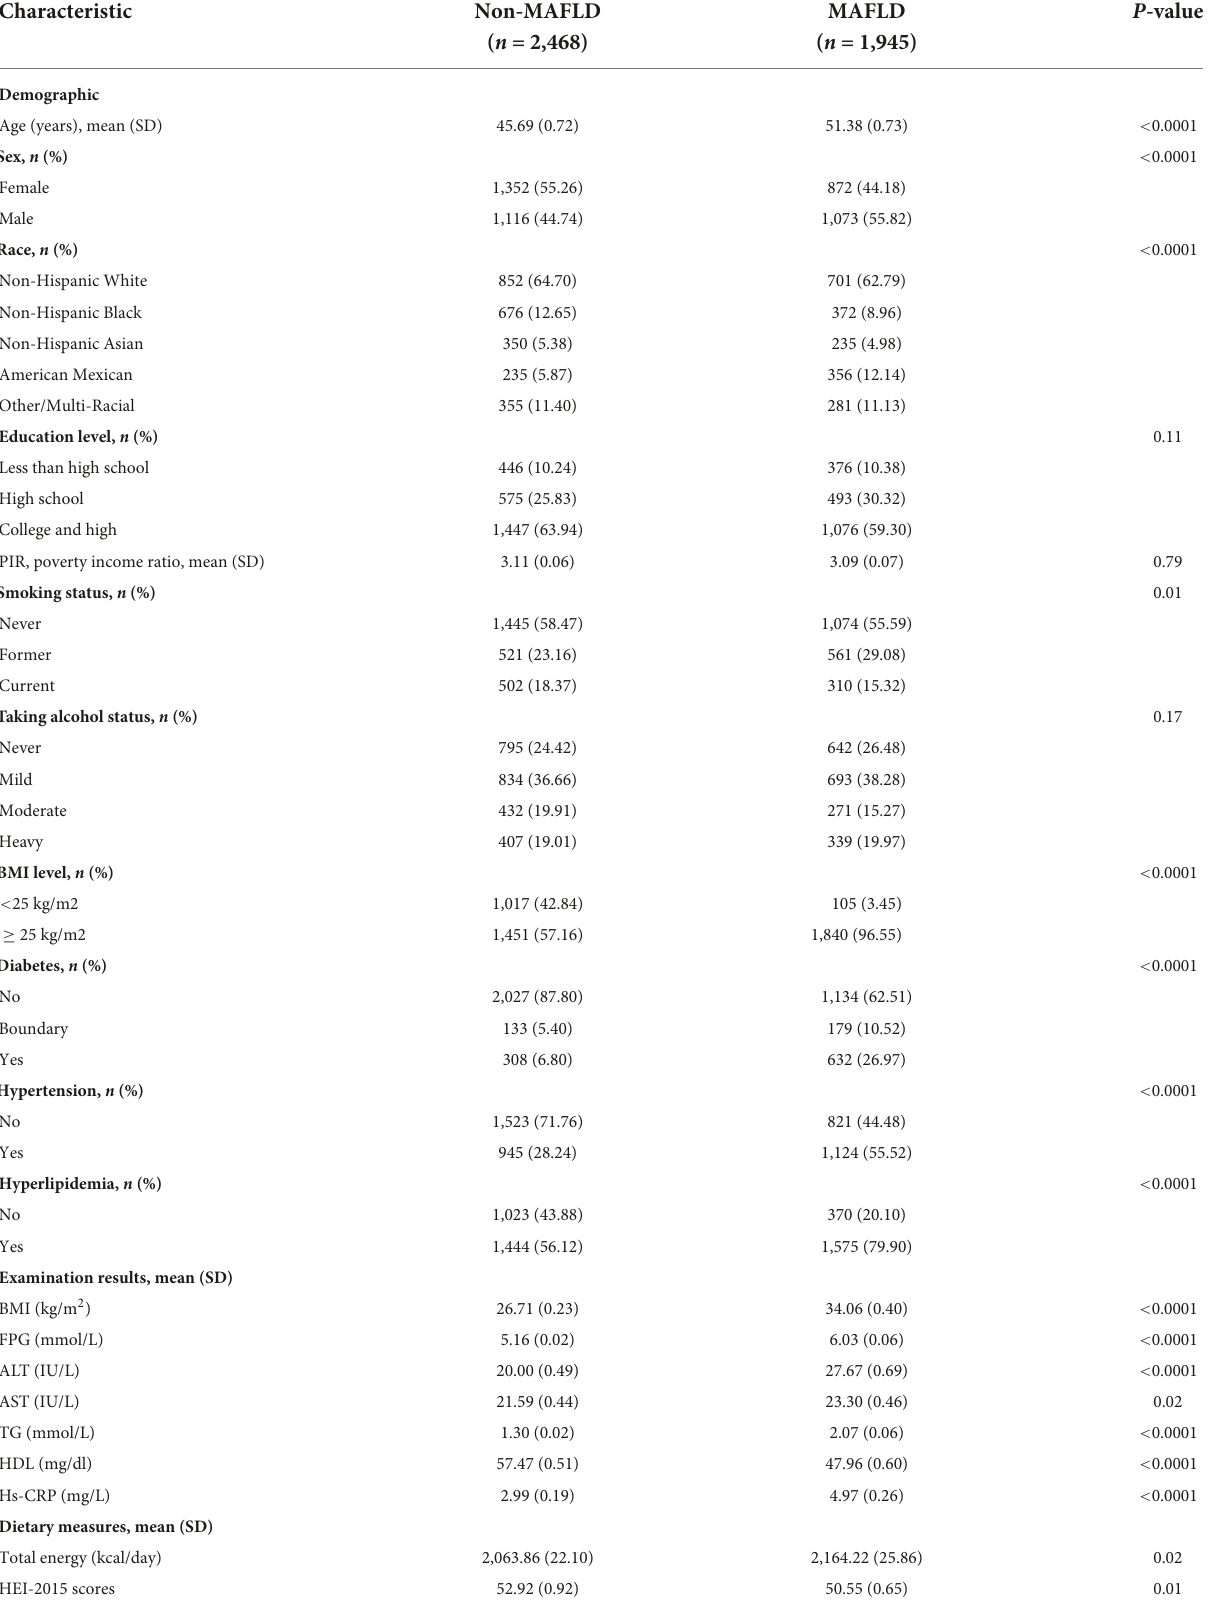
TABLE 1 Characteristics of participants by the metabolic associated fatty liver disease (MAFLD) status, weighted. Characteristic